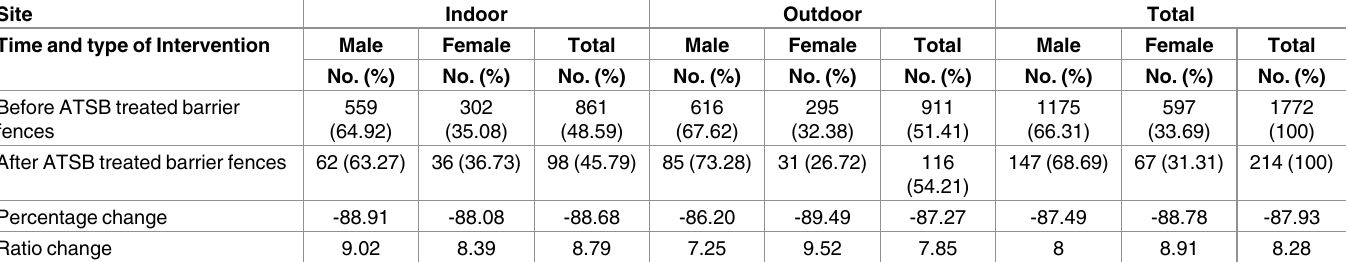
Table 5. The comparison of P . papatasi frequency caught with sticky traps before and after treatment (ATSB treated barrier fences) in Kooh-Sefid, Markazi District, Qom province, 2014–2015. Site